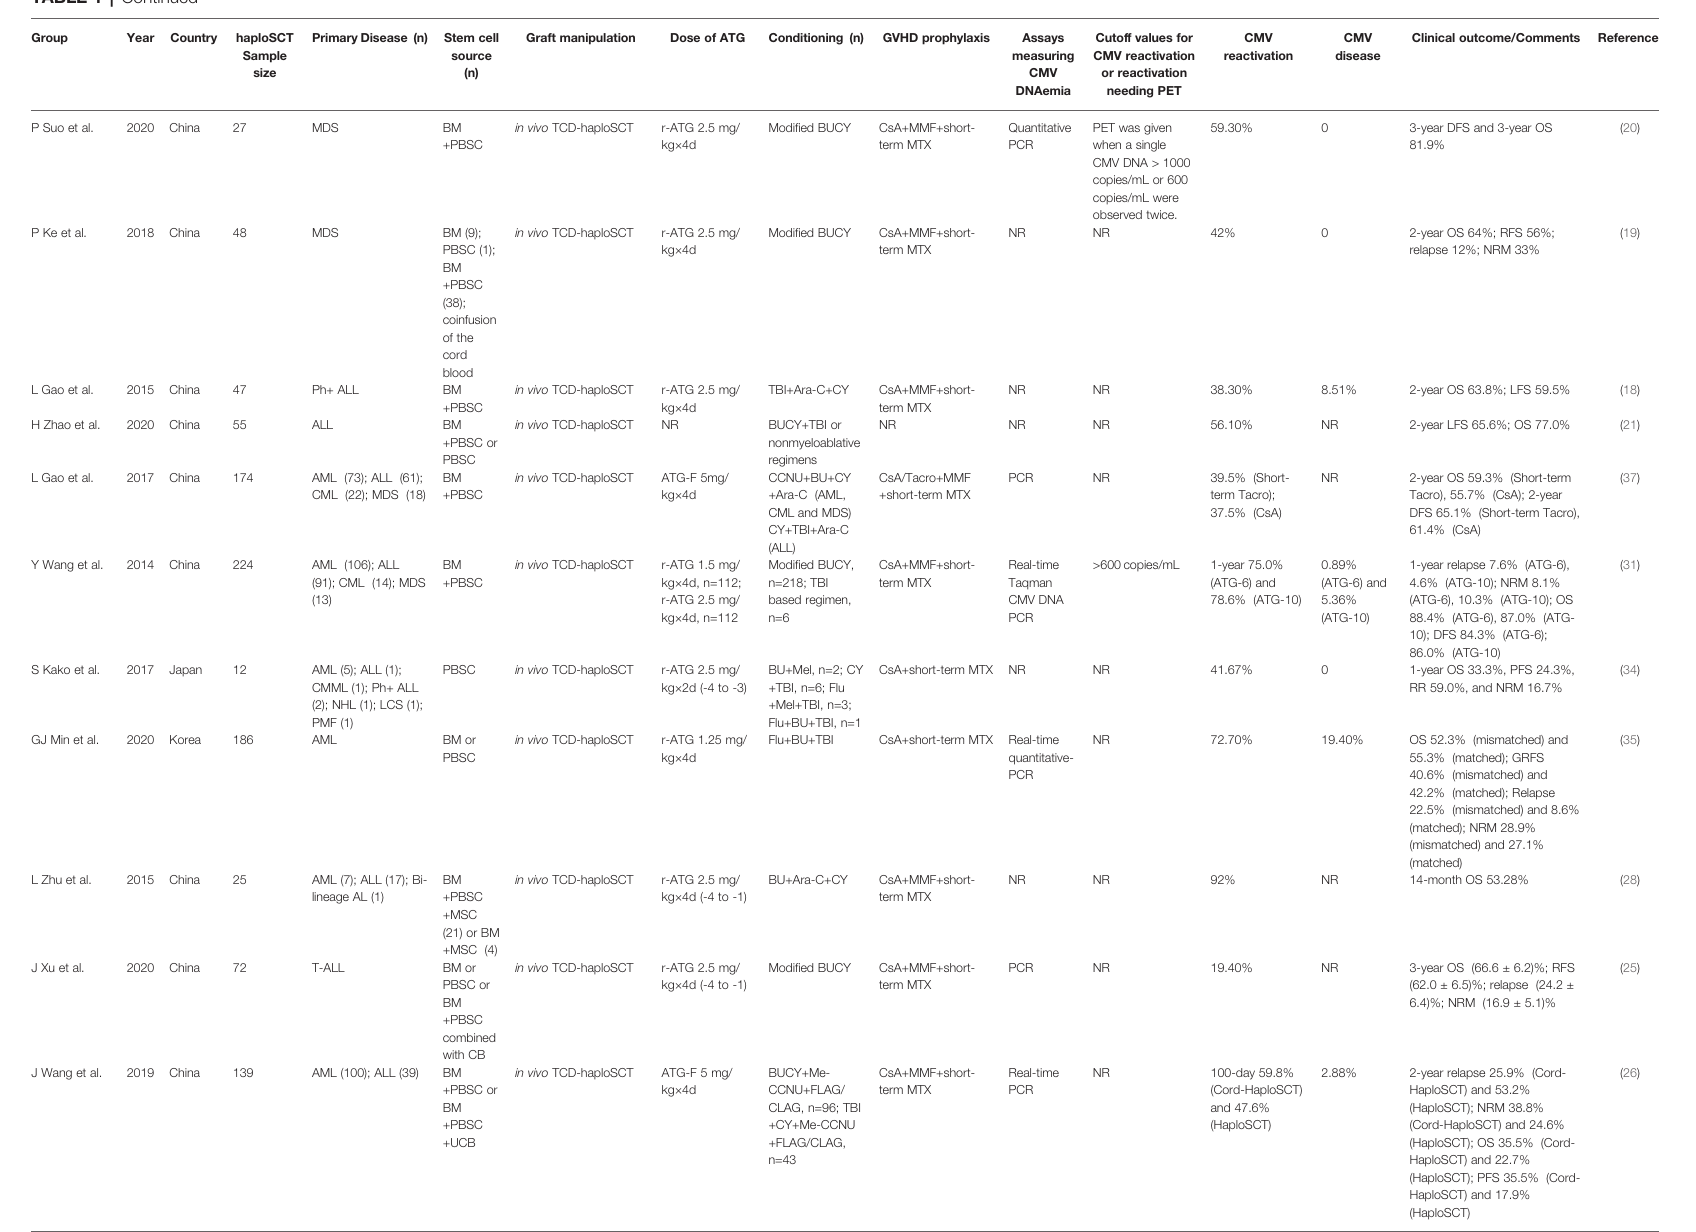
2-yearrelapse 25.9% (Cord- HaploSCT)and 53.2% (HaploSCT); NRM 38.8% (Cord-HaploSCT) and 24.6% (HaploSCT); OS 35.5% (Cord- HaploSCT)and 22.7% (HaploSCT); PFS 35.5% (Cord- HaploSCT)and 17.9% (HaploSCT)